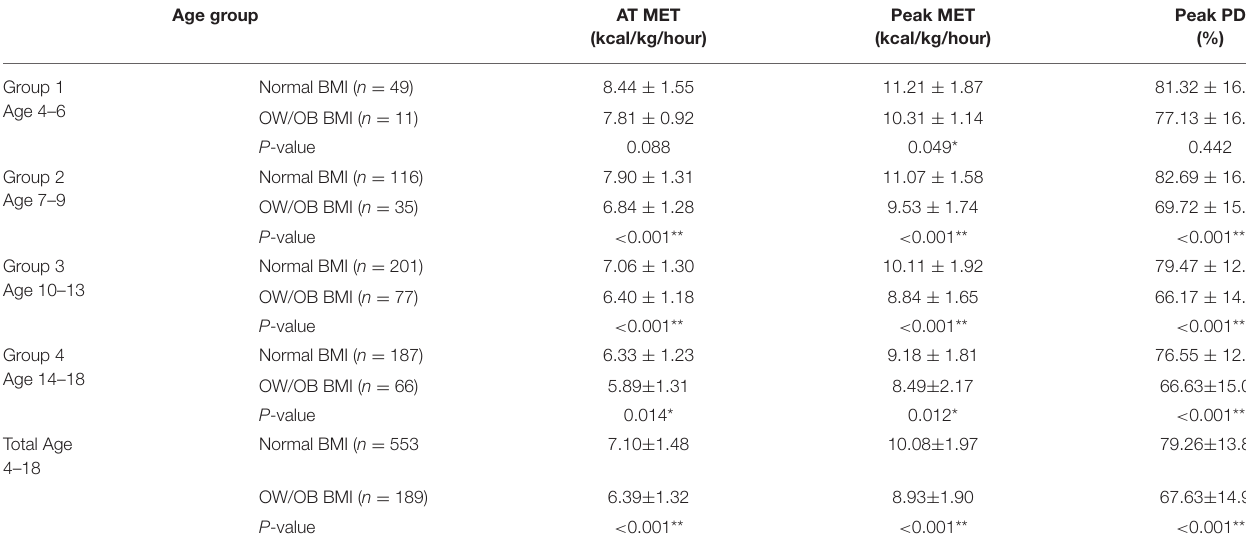
TABLE 4 | Comparison of cardiopulmonary fitness during exercise testing between children with normal and overweight/obese body mass index in relation to age group. Age group AT MET